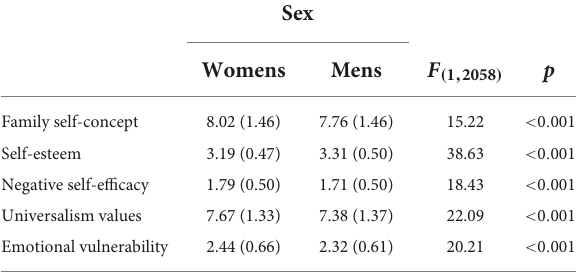
TABLE 4 Means, standard deviations, and univariate F -values for self (family self-concept, self-esteem, and negative self-adequacy), universalism values, and emotional vulnerability by children